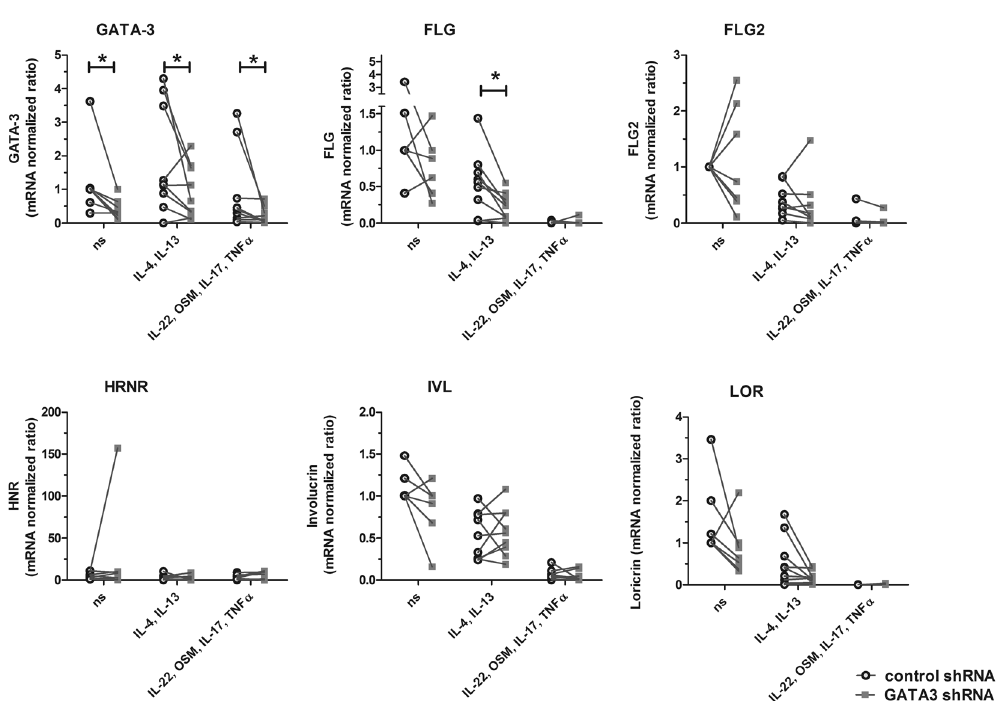
Figure 4. Influence of GATA3 silencing on the expression of genes encoding for major epidermal barrier proteins. GATA3 silenced and control treated keratinocytes were incubated with the indicated stimuli for 3 days (25 ng/ml were used for IL-4, IL-13, OSM and IL-17 and 10 ng/ml were used for IL-22 and TNF α ). Subsequently, qRT-PCR was performed and the expression of GATA3, LOR, IVL, FLG, FLG2, and HRNR were analysed. Relative mRNA expression levels normalized to PGK1 are shown. n = 7–8 independent experiments with keratinocytes from different donors. P values depict statistical values estimated with t-test (paired-t-test or Wilcoxon signed rank test). * p <